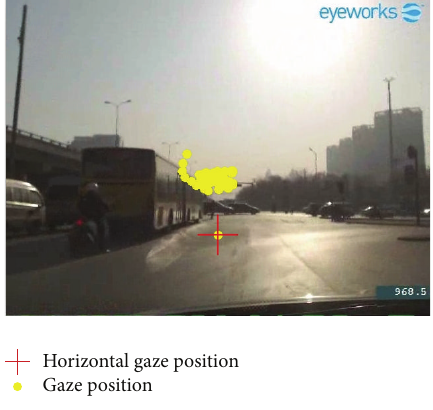
Figure 7: Driver’s horizontal gaze